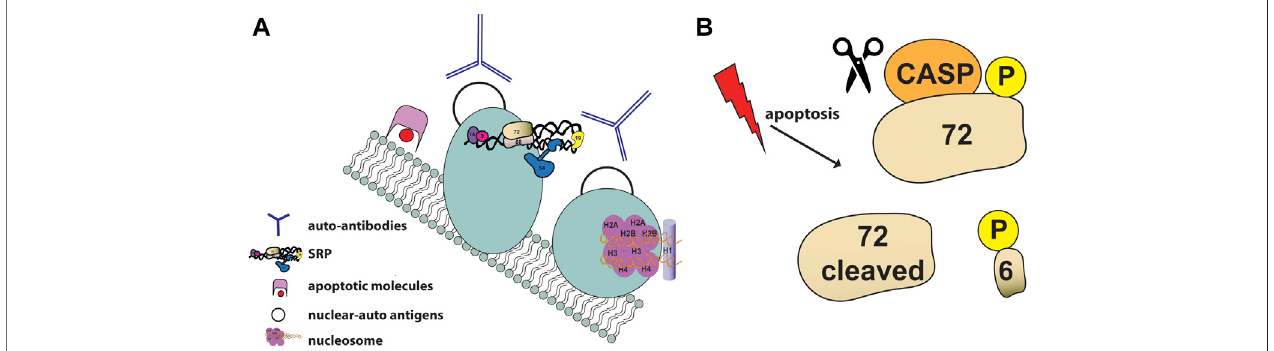
FIGURE 5 | SRP and apoptosis (A) Schematic illustration of SRP autoantigens as constituents of membrane-bound blebs (shown as light blue circles) on the surface of apoptotic cells. Apoptotic blebs display many nuclear auto-antigens (shown as black empty circles) such as nucleosomes (shown in purple) and accumulate apoptotic molecules (shown in pink and red). Auto-reactive antibodies (shown as blue Y) generated against nuclear antigens are showns around the blebs (B) SRP72 is phosphorylated and cleaved during apoptosis. The proteolytic cleavage of SRP72 by caspases produces a 6 kDaC-terminal phosphorylated peptide of unknown fate.